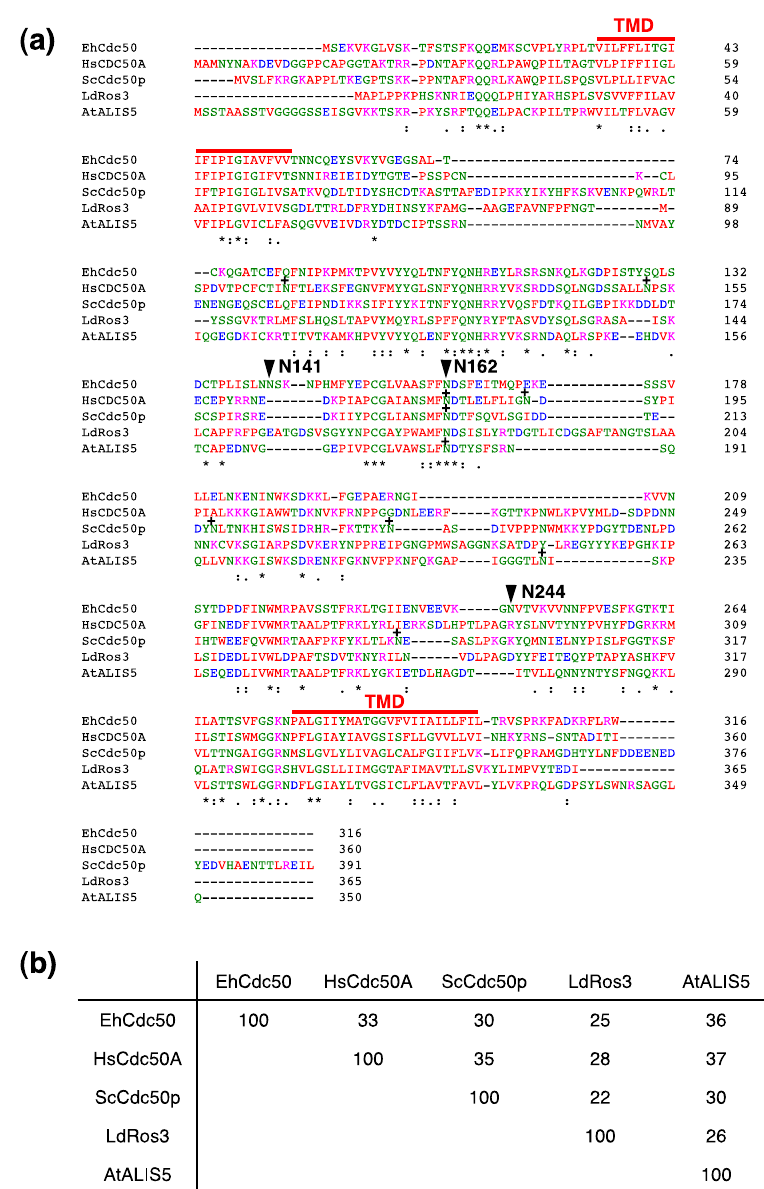
Figure A1. Amino acid sequence alignment of Cdc50 homologues. ( a ) Sequences were aligned using ClustalW2 server (https://www.ebi.ac.uk/Tools/msa/clustalw2/). Accession numbers were: E. histolytica EhCdc50 (EHI_142740), human CDC50A (Q9NV96), S. cerevisiae Cdc50p (YCR094W), L. donovani LdRos3 (ABB05176) and A. thaliana ALIS5 (Q8L8W0). N -glycosylation sites of EhCdc50 were predicted using NetNGlyc 1.0 Server (http://www.cbs.dtu.dk/services/NetNGlyc/) and depicted with black arrowheads. N -glycosylation sites of Cdc50 homologues reported in humans, S. cerevisiae and A. thaliana , are indicated with small black crosses. Two transmembrane regions of EhCdc50 were predicted with the TMHMM Server v.2.0 (http://www.cbs.dtu.dk/services/TMHMM/) and depicted with red lines and “TMD.” ( b ) Amino acid percentage identity matrix was created using the ClustalW2